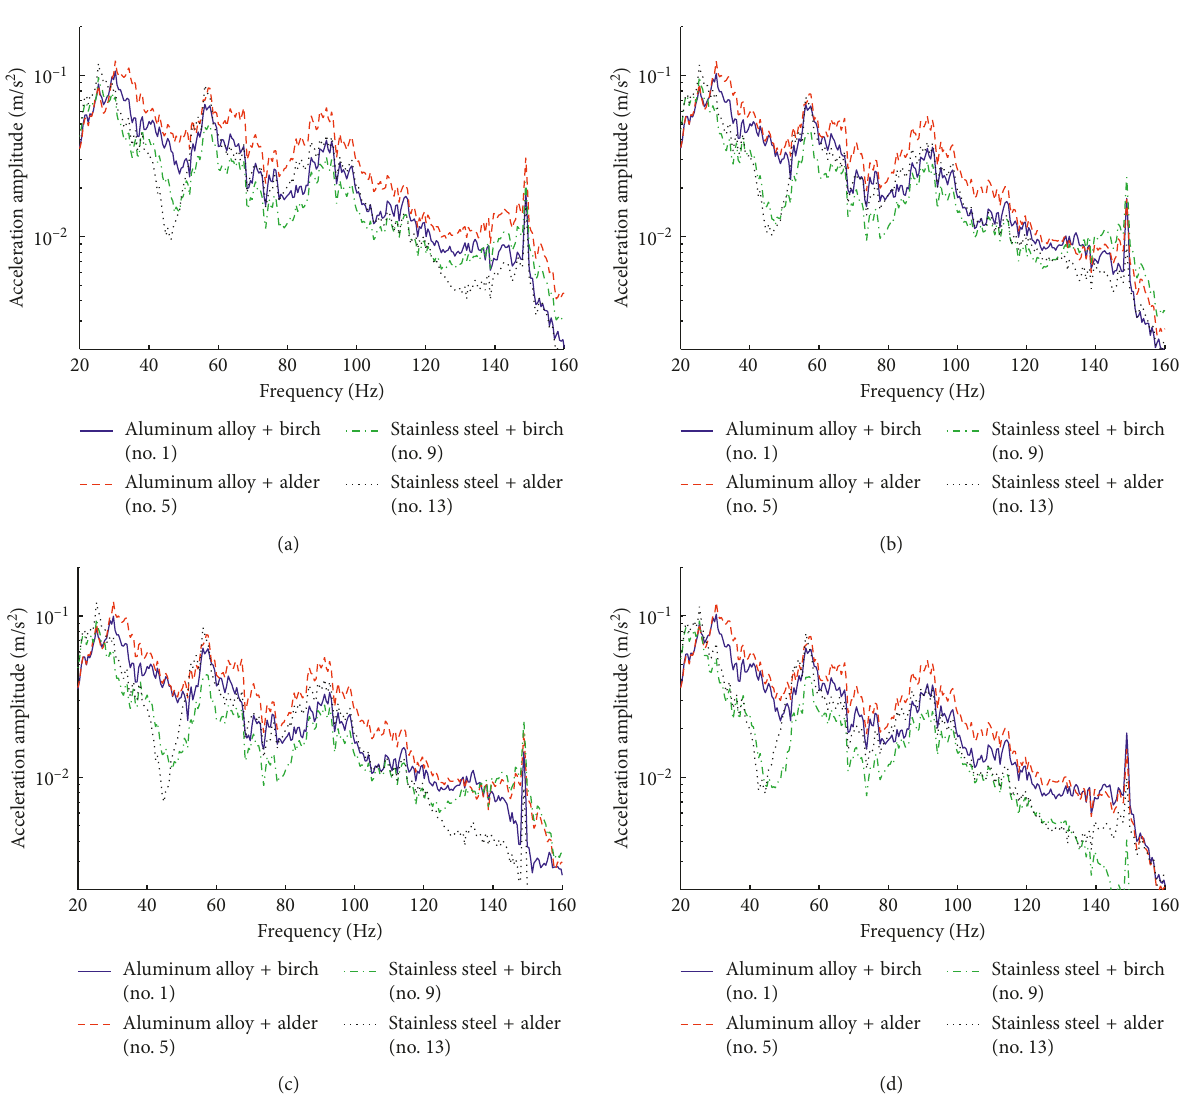
Figure 18: Time domain results of the vibration acceleration response. Panel thickness of (a) 0.5 mm; (b) 0.8mm; (c) 1.0mm; and (d)